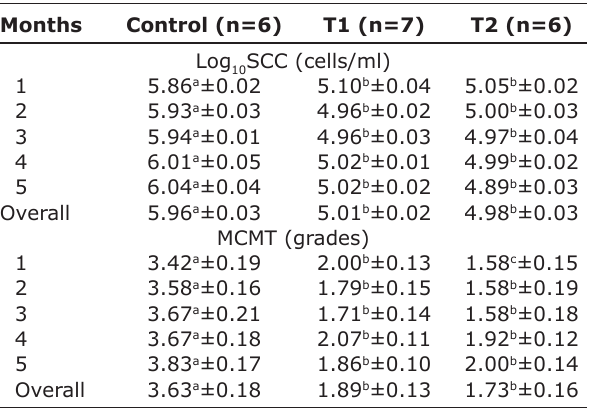
Table-3: Milk testing parameters for udder health/subclinical mastitis in Jersey crossbred cows.